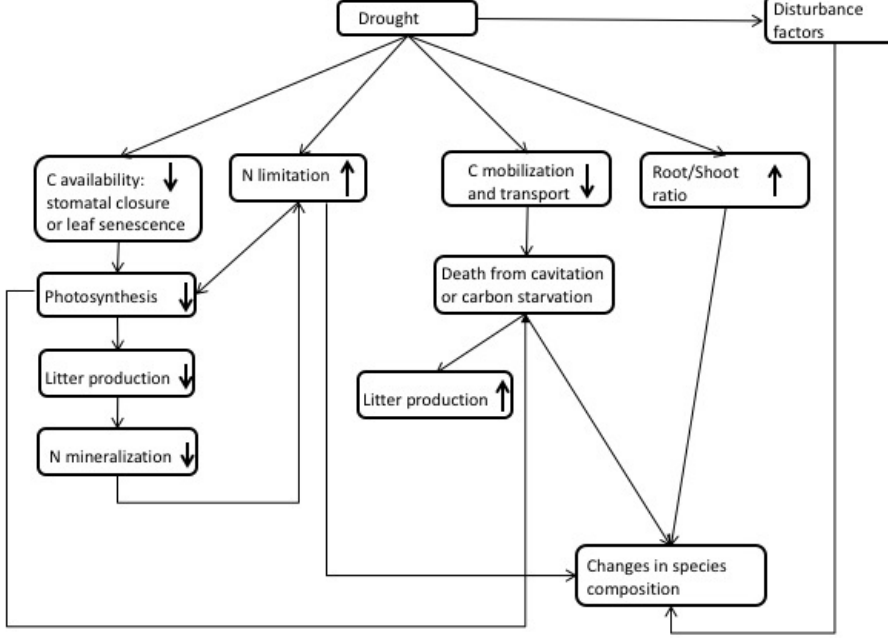
Figure 2. Effects of drought on ecosystems. Up arrows represent an increase, and down arrows represent a decrease. Four main pathways exist: changes in C availability, increases in N limitation, changes to C mobilization and transport, and changes to biomass partitioning (i.e., root:shoot). Changes in C availability and N limitation both lead to decreases in photosynthesis, which has a positive feedback on N limitation when less biomass is contributing N to litter pools. Changes in C availability and a lack of C mobilization can lead to death from carbon starvation. Several pathways result in altered species composition from shifts in nutrient availability and competition. In general, the impacts from drought occur over short timescales (<5 years), while changes to species composition and disturbance occur over longer timescales.